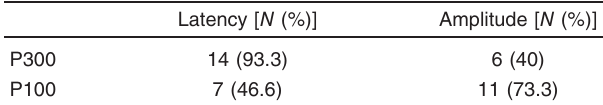
Table 4 Distribution of abnormal auditory P300 and visual P100 values